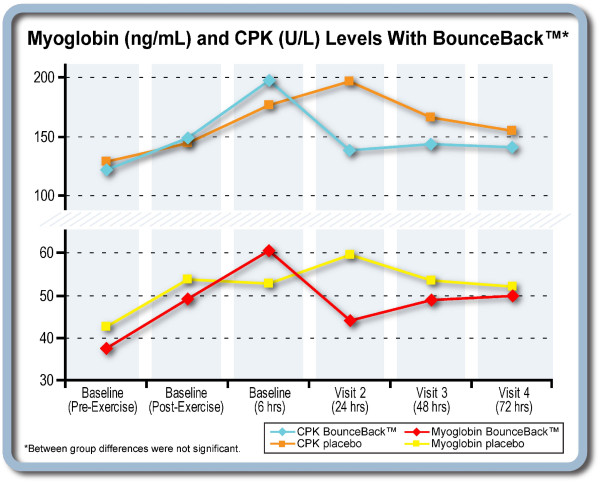
Myoglobin and CPK.